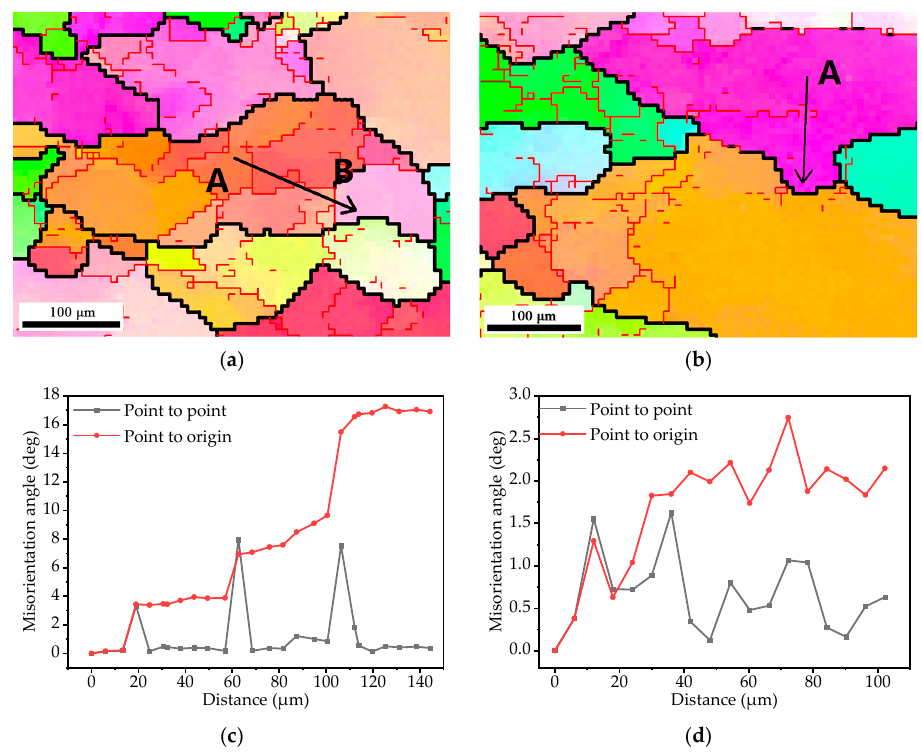
Figure 11. cDRX and dDRX of Ti − 65541 alloy in region A: ( a , b ) EBSD map, ( c , d ) the map of misorientation.